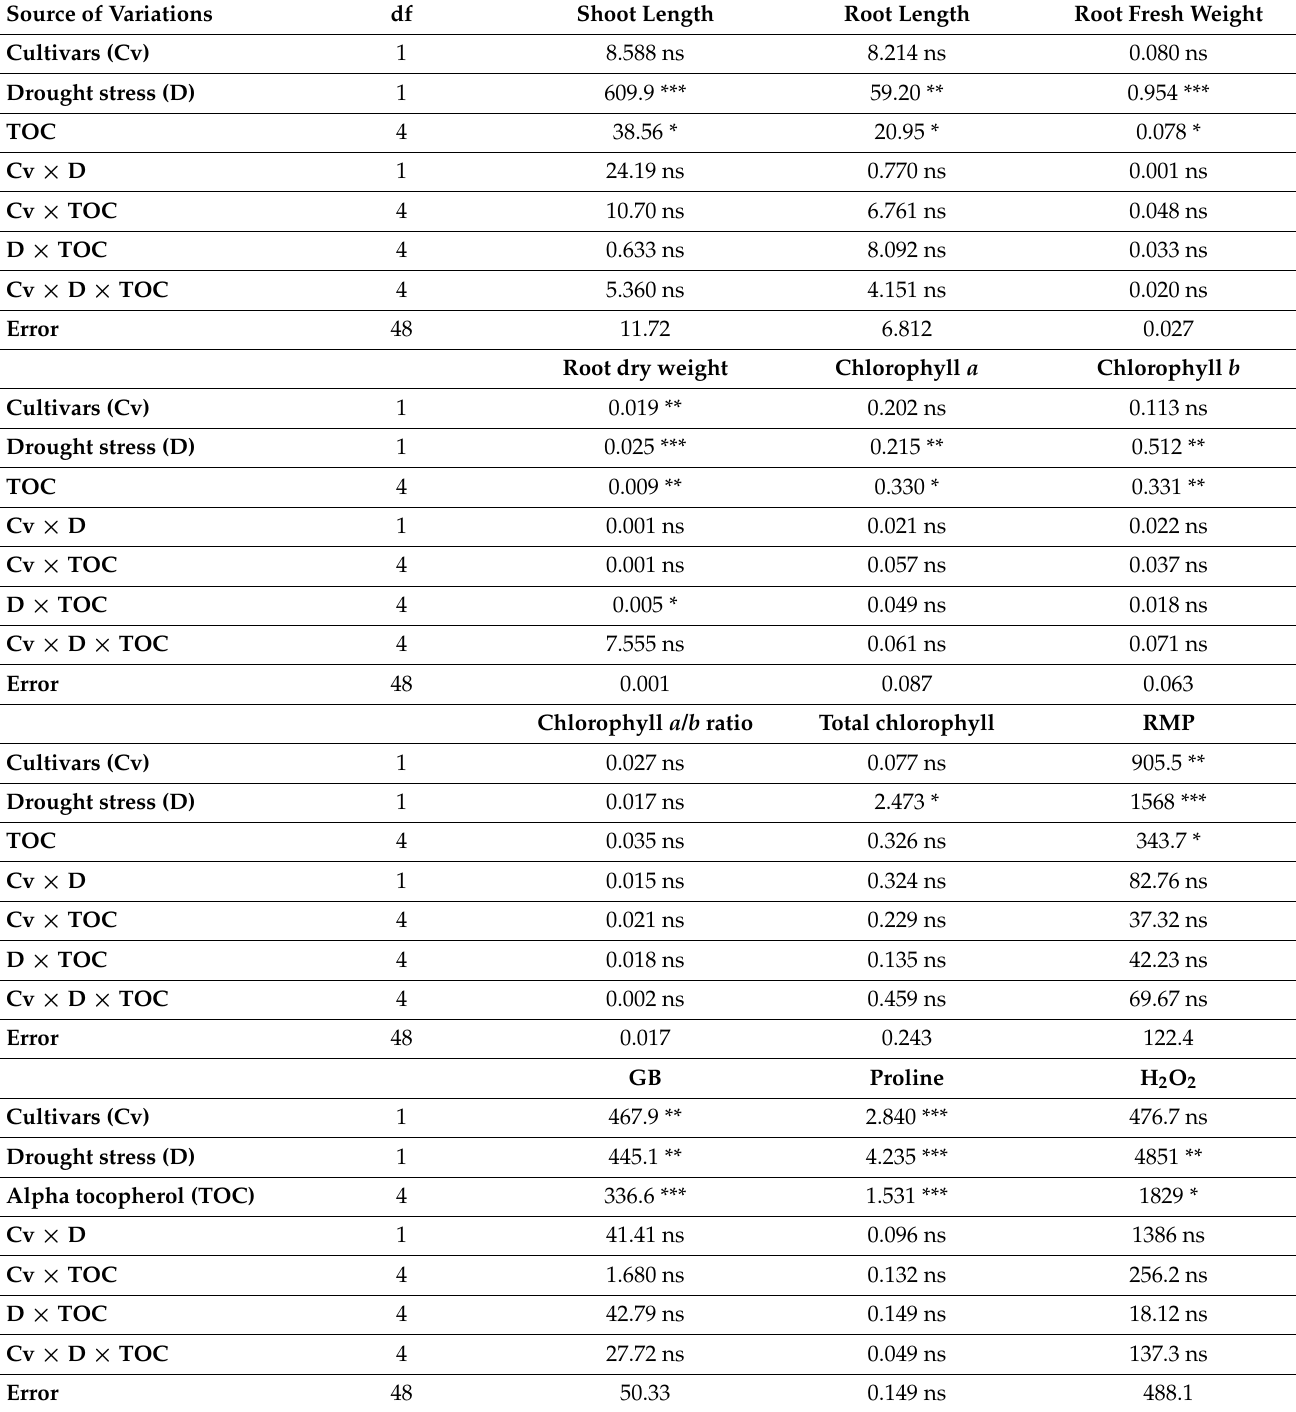
Table 1. Mean square values (ANOVA) for the growth and physiological, biochemical characteristics of eggplant ( Solanum melongena L.) subjected to exogenous application of alpha-tocopherol (TOC) under drought